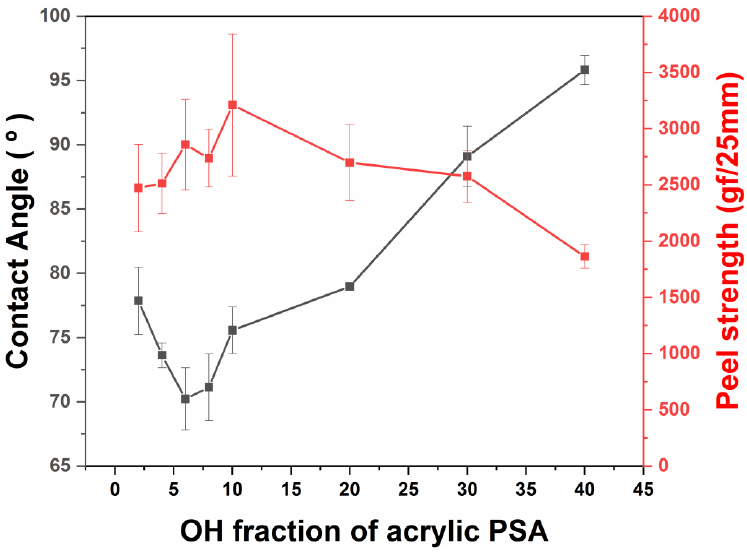
Figure 4. Surface contact angle and adhesive force analysis of acrylic PSA films for HEA